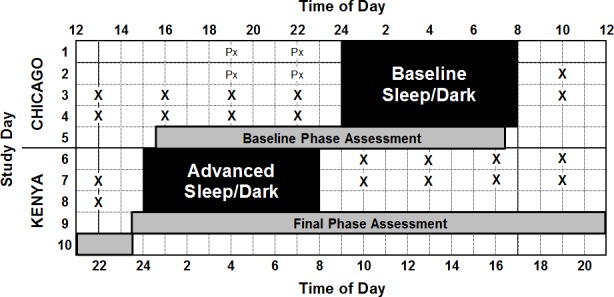
Protocol diagram.Time of day at the top is Chicago time, and time of day on the bottom is Kenyan time (9-h later than Chicago time). Study day is shown on the left. Black shading shows timing of scheduled sleep periods. Schedules were individualized for each participant to best match their habitual sleep times. This diagram shows the protocol for a participant on a 00:00–08:00 baseline sleep schedule. Days 1–4 were baseline during which participants remained on local, Chicago time (as indicated on the left). On days 6–9 the sleep schedule was shifted 9-h earlier (advanced) as though participants had traveled to Kenya, and the wall clocks in the bedrooms were changed to indicate the shifted, Kenyan time. During baseline days the sleep schedule was aligned with each participant’s circadian rhythms, whereas during advanced days the sleep schedule was misaligned. “X” shows the timing of the Automated Neuropsychological Assessment Metrics (ANAM) performance battery and “Px” shows the timing of practice ANAM tests. Tests were given relative to each participants scheduled sleep times; 2 h after waking, and then every 3 h with a total of 5 tests per day. Light grey shading shows the timing of circadian phase assessments, during which the dim light melatonin onset (DLMO) was assessed.